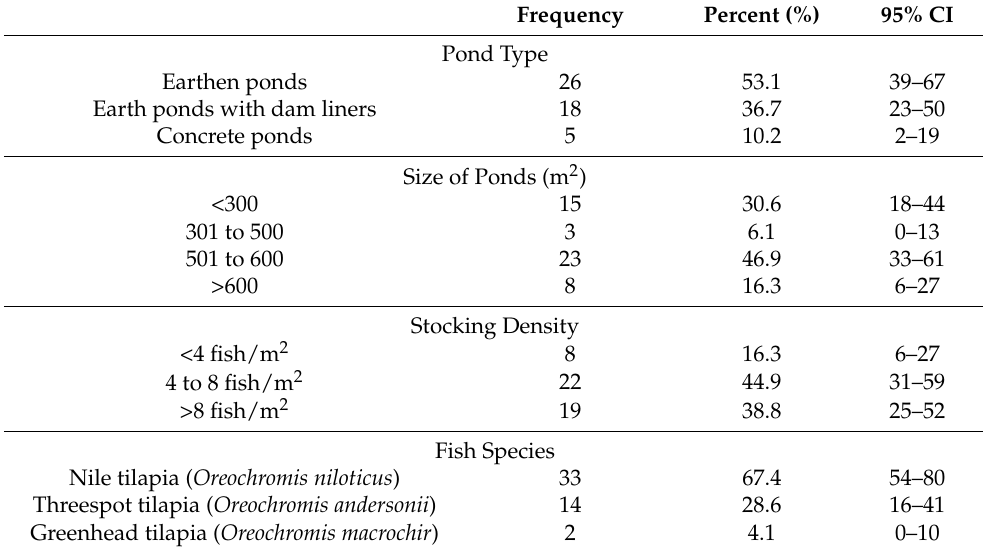
Table 1. Farm characteristics, such as pond type and size, stocking density, and fish